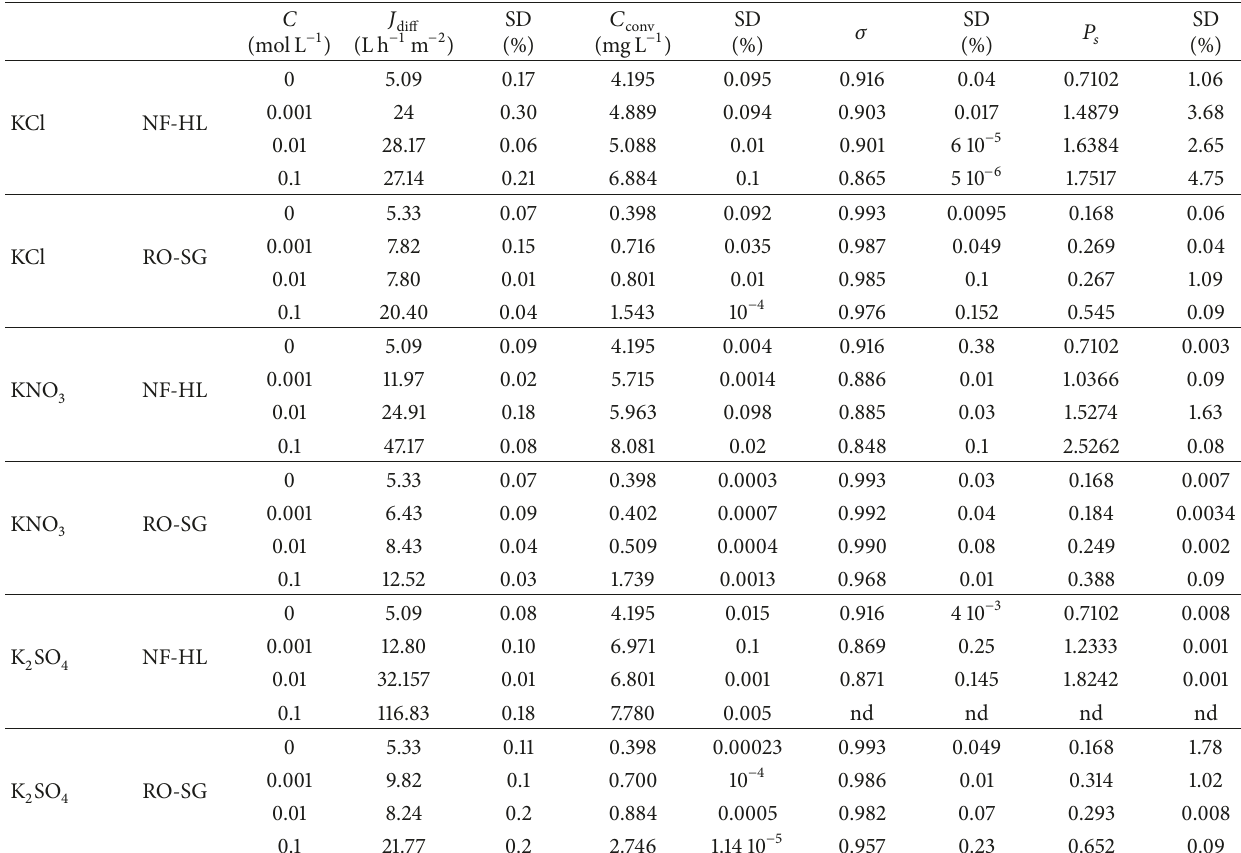
Table 2: Transport parameters ( 𝜎 and 𝑃 𝑠 ), diffusive flux 𝐽 diff and 𝐶 conv of hexavalent chromium in presence of different salts ( 𝐶 Cr ( VI ) = 50 mgL −1 , 𝑌 = 50%, pH = 8, and 𝜃 = 25 ∘